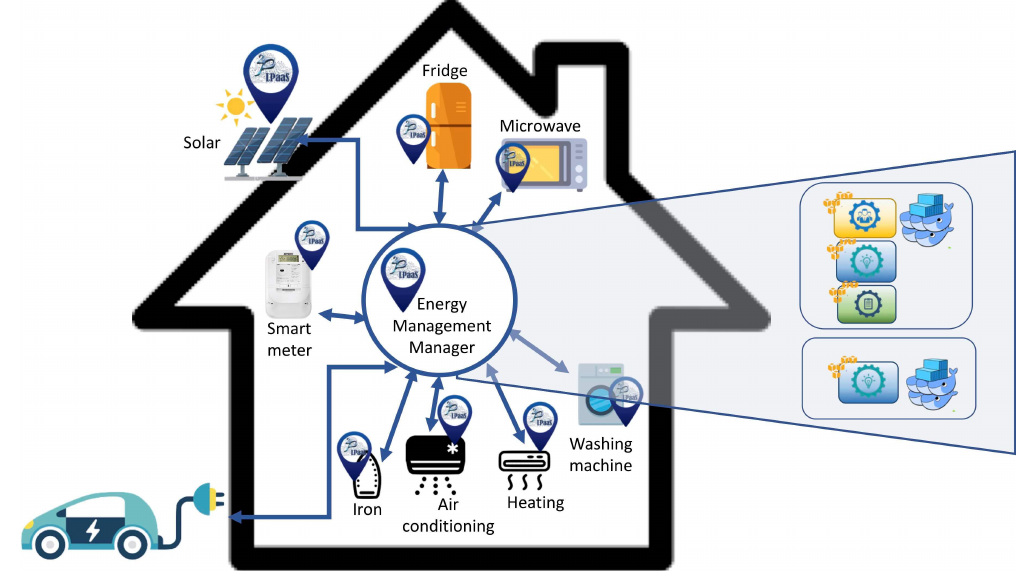
Figure 7. The LPaaS energy management in the smart